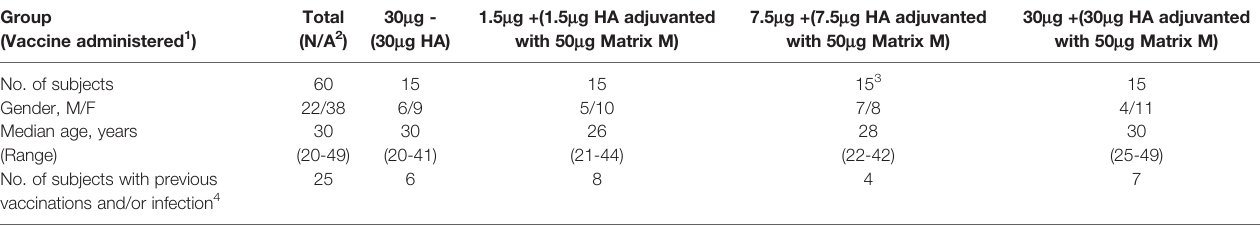
TABLE 1 | The demographics of the subjects enrolled in the study. Group (Vaccine administered 1